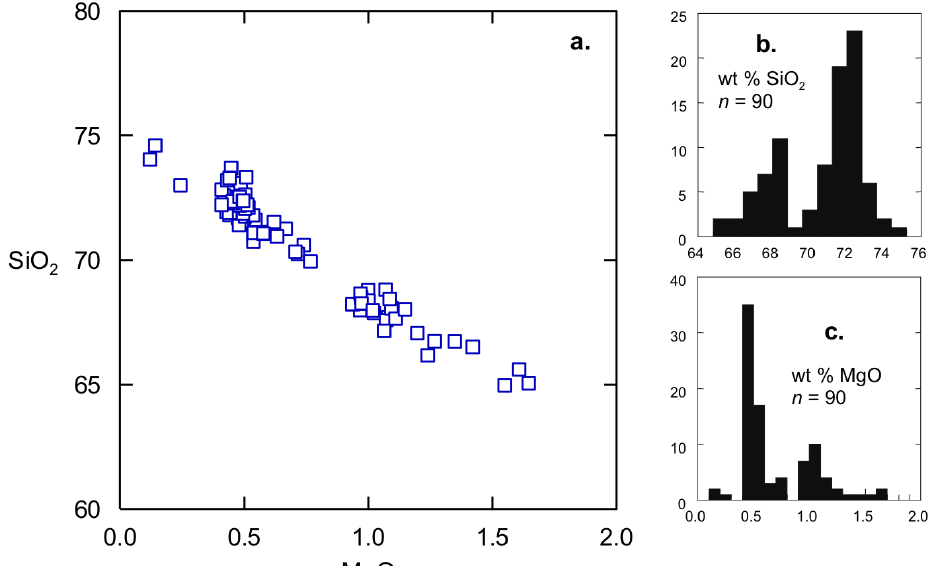
Figure 8. ( a ) SiO vs . MgO in groundmass glass. A gap occurs at approximately 69 wt % 2 SiO and 0.8 wt % MgO; This gap reveals a bimodal distribution of glass compositions 2 shown in histograms for ( b ) wt % SiO ; and ( c ) wt % MgO in glass 2